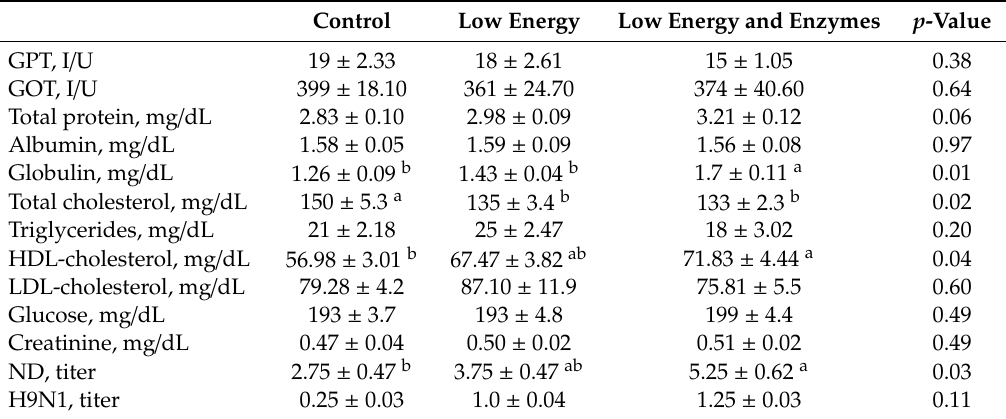
Table 4. E ff ect of NSP enzyme supplementation on plasma parameters in broilers.